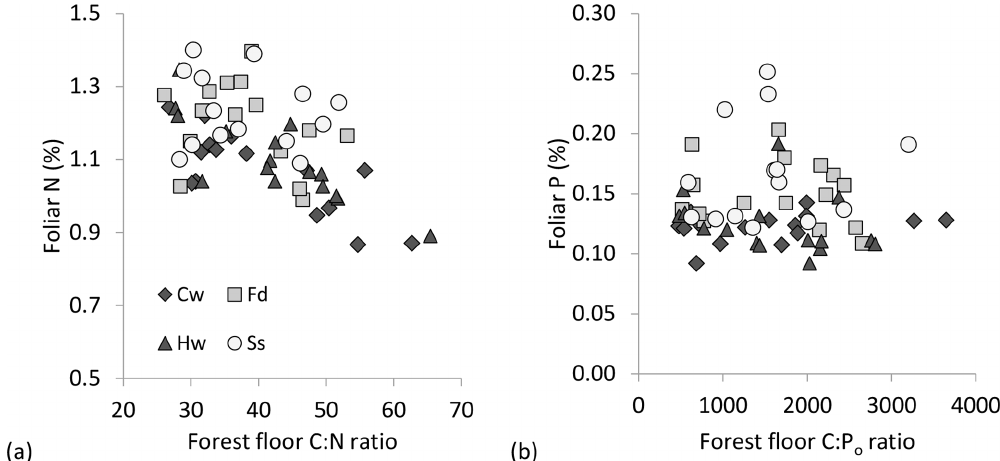
Figure 5. (a) Foliar N (%) in relation to forest floor C:N molar ratio and (b) foliar P (%) in relation to forest floor C:P o ratio: Thuja plicata (western red cedar = Cw; Pseudotsuga menziesii (Douglas fir) = Fd; Tsuga heterophylla (western hemlock) = Hw; Picea sitchensis (Sitka spruce) =